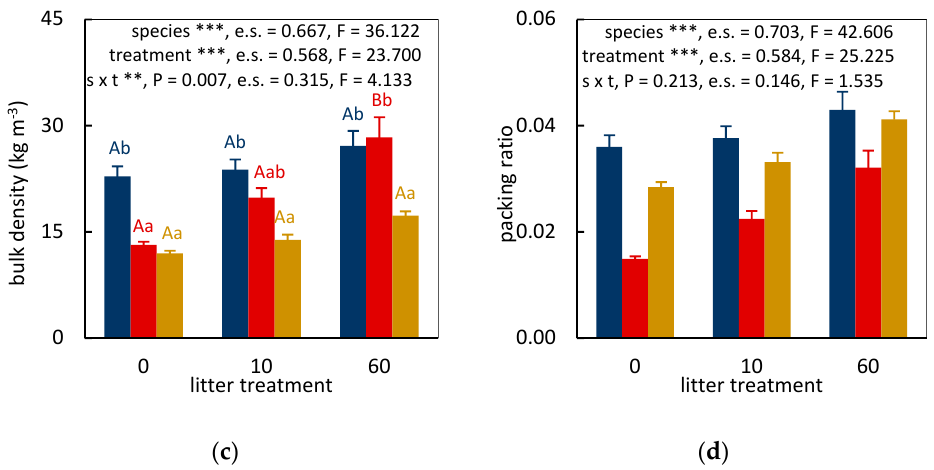
Figure 2. Means and standard errors with results of the Two-Way ANOVA and pairwise contrasts with Tukey’s adjustment for multiple comparisons. ( a ) score to the first principal component (PC1), ( b ) score to the second principal component, ( c ) bulk density (BD), and ( d ) packing ratio. Species are consistently shown as indicated in the legend of Figure 2a (CS = Ceratonia, siliqua , PH = Pinus halepensis , and QP = Quercus pubescens ). Treatments are indicated as defined in the material and methods section. Significance of the effects of species, treatment, and their interactions (s × t) are indicated. Degrees of freedom were the same in all analyses: 2 for species and treatment, 4 for interactions, and 36 for residuals. The P value is given only if P ≥ 0.01. Different capital letters indicate statistically significant differences (P ≤ 0.05) between treatments within a single species. Different lowercase letters indicate statistically significant differences between species within a single treatment. Exceptionally, for PC2 (b) only species were compared since the effect of the treatment and s × t interactions were not significant, and for PR (d) a comparison was made between species and between treatments separately. For (b), a different capital letter next to the species coding in the legend indicates statistically significant between species differences. In (d) all species and all treatments differed from each other. Effect size (e.s.), calculated as the partial eta-squared, is reported. **P ≤ 0.01 and ***P ≤ 0.001.